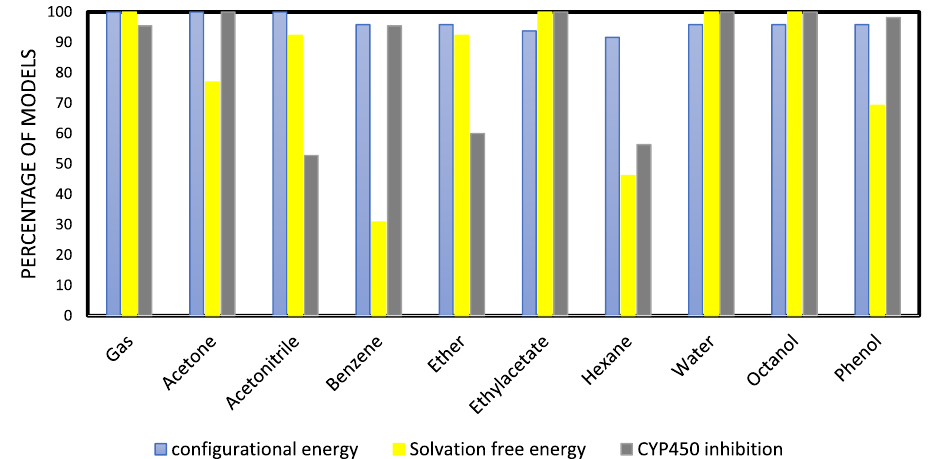
Fig. 5 Percentage of the presence of studied mediums in selected models for different considered applications. Perturbation of Hamiltonian by different solvents might have different impacts on predictability depending on the property of interest. Table 2 Percentage of the presence of studied energy attributes in selected models in different